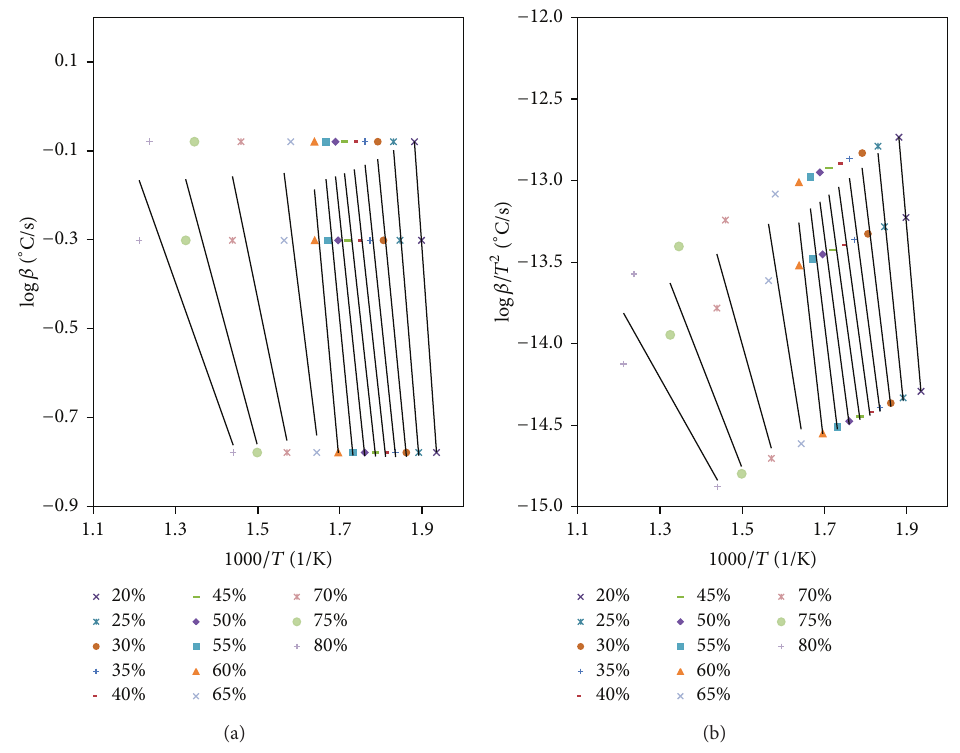
Figure 5: Linear plots for determination of the activation energy at different values of conversion for corn stover: (a) FWO method and (b) KAS method.